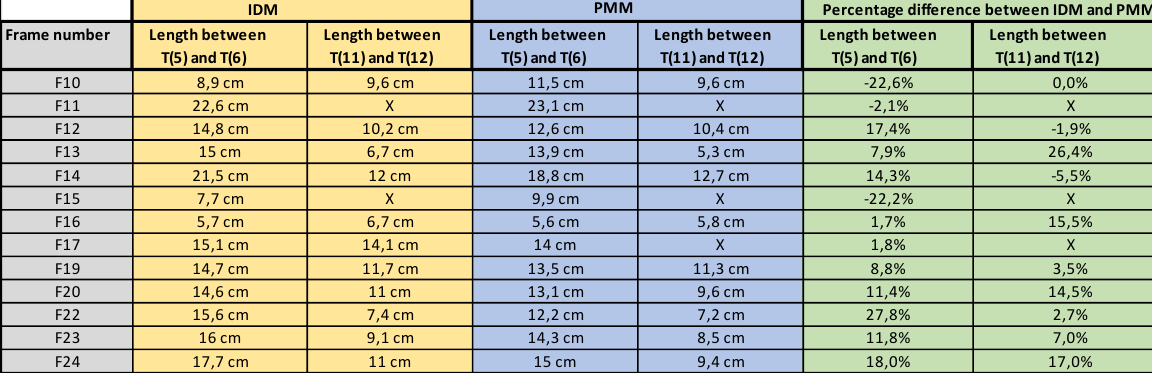
Table 2. Measurements distances between different tenons of some frames of the shipwreck. “T” stands for “tenon”. In yellow, the interpretative drawn measurements (IDM). In blue, the photogrammetry model measurements (PMM). In green, the percentage difference between the IDM and the PMM. The total margin of error of the percentage difference between the IDM and the PMM for the length between the measurements of tenons 5 and 6 is of 13.3% and for the length between the tenons 11 and 12 is of 9.4%.